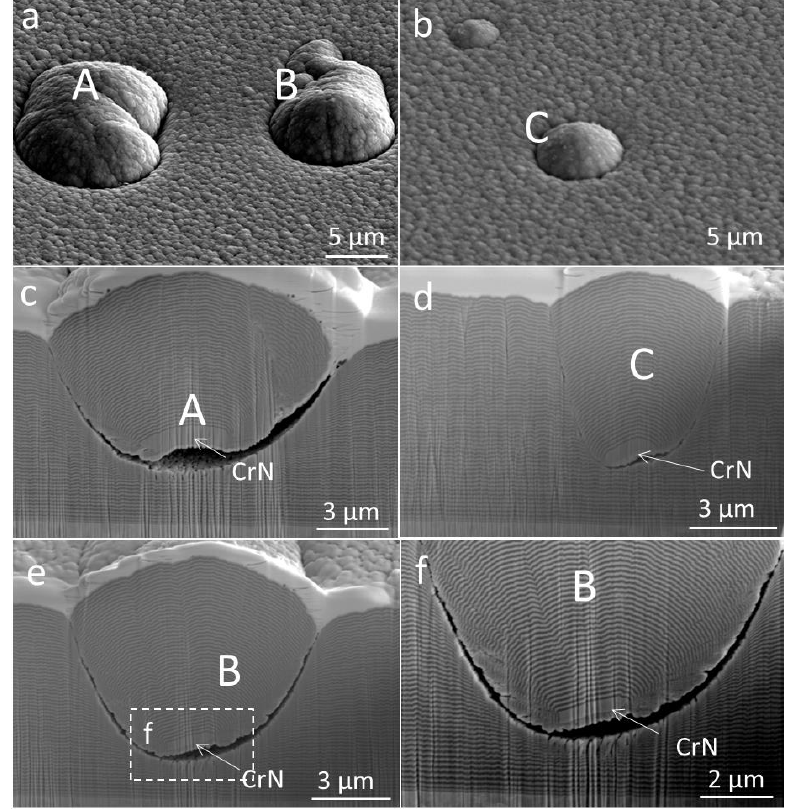
Figure 14. Top-view SEM images ( a , b ) and SEM images of the FIB cross-sections ( c – f ) of three nodular defects (A – C) in the NL-TiAlN/CrN coating. All three defects formed at the site of Cr-based flakes, which were incorporated in the coating at the same depth. All three flakes probably came from the same source. We believe that they originate from arcs occurring at the perimeter of the chromium target.